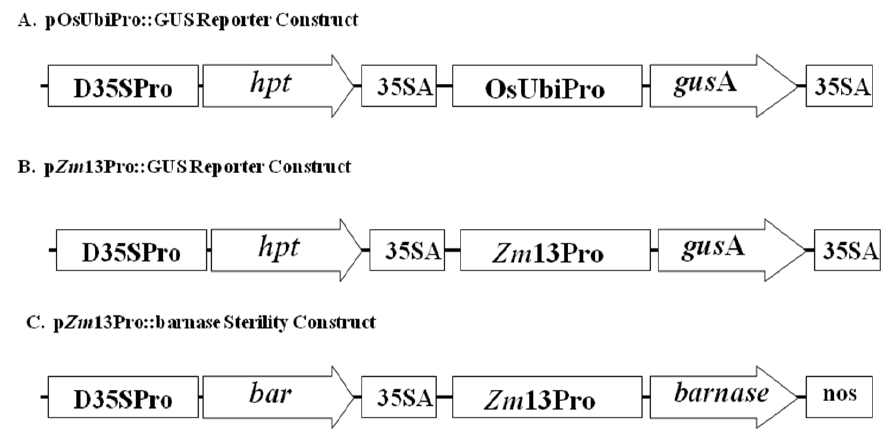
Figure 1. Diagrammatic representation of the test constructs. ( A ) For constitutive expression and as a positive GUS control, a rice ubiquitin promoter (OsUbiPro) drives expression of a gusA with a 35A 3' termination signal; this was linked to hpt (hygromycin phosphotransferase) driven by the double enhancer version of the Cauliflower Mosaic Virus 35S promoter (D35S) as a plant selectable marker for hygromycin B resistance; ( B ) The Zm13 promoter driving the reporter gene gusA with a 35A 3' termination signal was designed to test tissue and developmental specificity; ( C ) The Zm13 promoter driving the cytoxin barnase gene with a nos 3' termination signal linked to a D35S:: bar ::nos cassette as a selectable marker cassette conferring herbicide